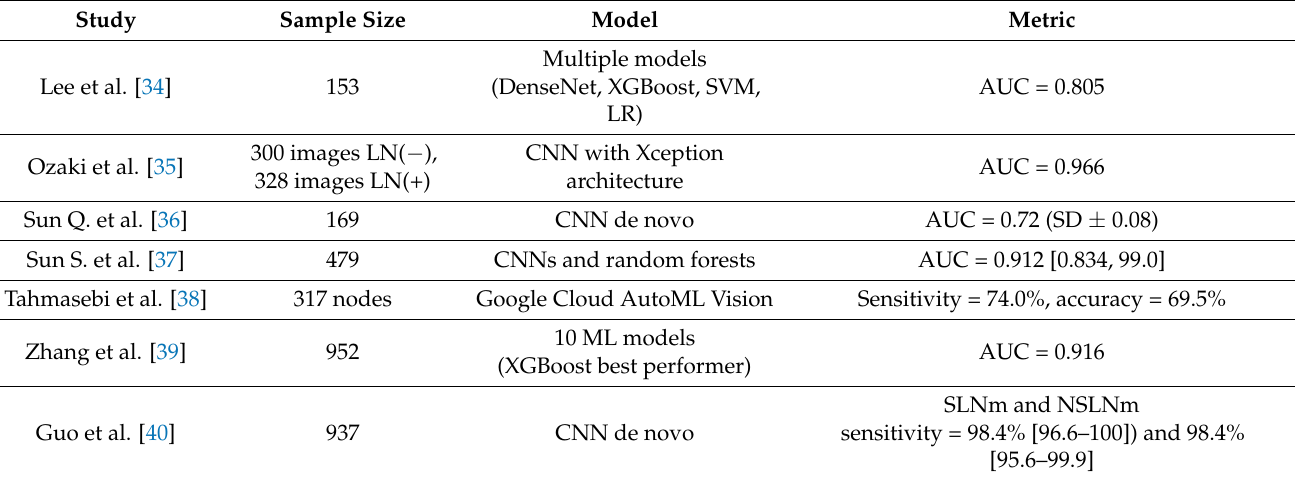
Table 2. Summary of studies using ultrasound radiomics for breast cancer lymph node